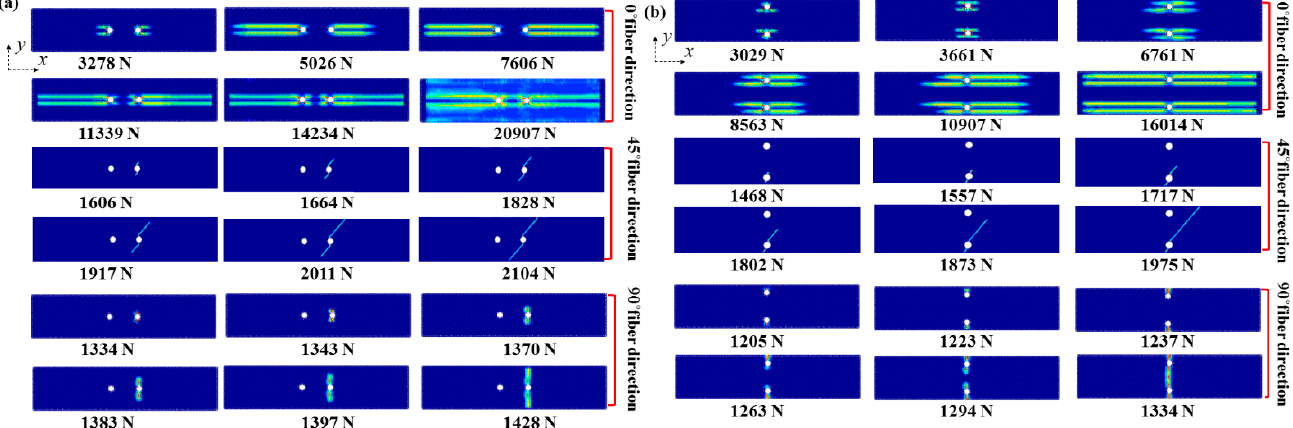
Figure 4. Observation of crack propagation in unidirectional composite plates with one hole for three different fiber directions.